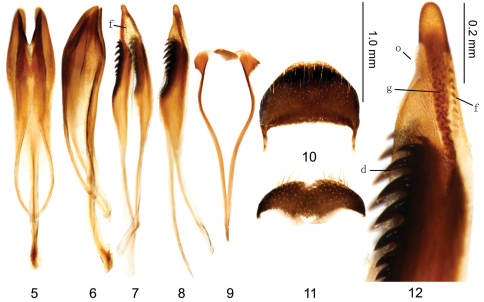
Male terminalia of Tillicera auratofasciata, from Tonkin 5–6 tegmen (5 dorsal view 6 lateral view) 7–8 phallus (7 ventral view 8 lateral view) 9 spicular fork 10 tergum VIII 11 sternum VIII 12 phallus, lateral view. Abbreviations: d = dorsal denticles f = file-like structures on phallic ventral membrane g = granular structures; o = median orifice.